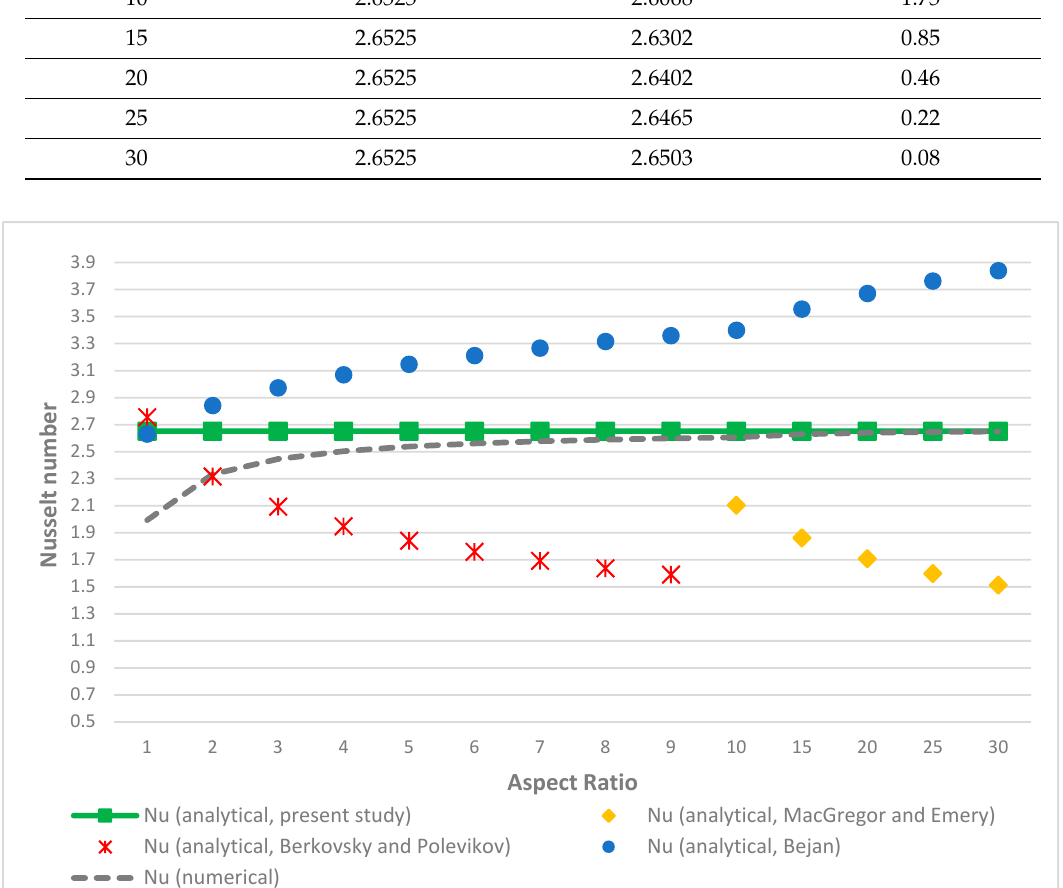
Figure 8. Variation of Nu for the analytical solution of this present study, the analytical solutions of Kimura and Bejan [25], MacGregor and Emery [30], Berkovsky and Polevikov [36], and the numerical solution at varying A and for Ra = 10 4